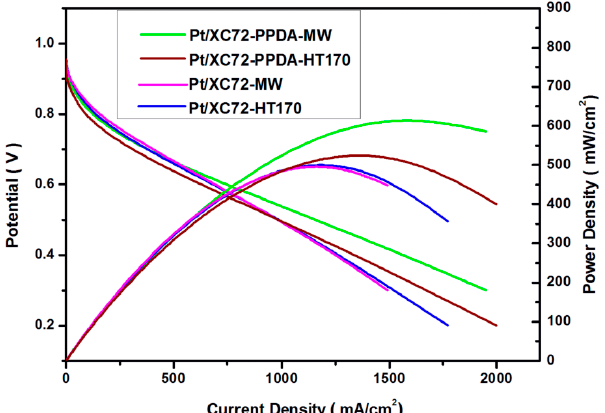
Figure 9. Electrocatalytic polarization and power density curve of PEMFC based on different catalyst supports. The fuel cell temperature was at 70 °C. The flow rates of H 2 and O 2 flows are set at 0.1 and 0.2 L · min − 1 , respectively.